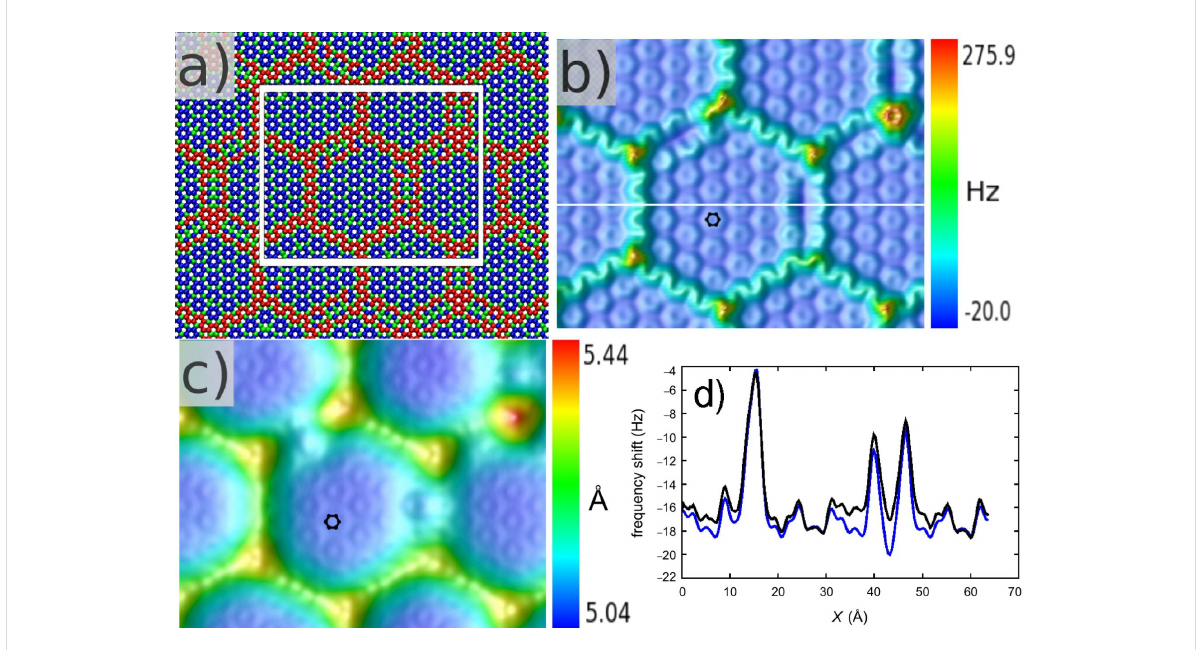
Figure 3: (a) Atomic structure of the buckled graphene on SiC with the height of graphene atoms classified in three categories: red, blue and green are the colors for the highest, the intermediate and the lowest carbon atoms, respectively. (b) Calculated graphene FM-AFM image with H set = 3.8 Å along the white box in (a). The Δ f corrugation is 295.9 Hz. The image size is 63.9 × 50.1 Å 2 . The small black hexagon corresponds to a carbon ring of the surface. (c) FM-AFM calculated graphene image with Δ f set = − 12.5 Hz along the white box in (a). The height corrugation is 0.4 Å (5.44 Å to 5.04 Å). The image size is 63.9 × 50.1 Å 2 . (d) Scanlines above the white line in (b) for the frozen-atoms (blue) and free-atoms (black)